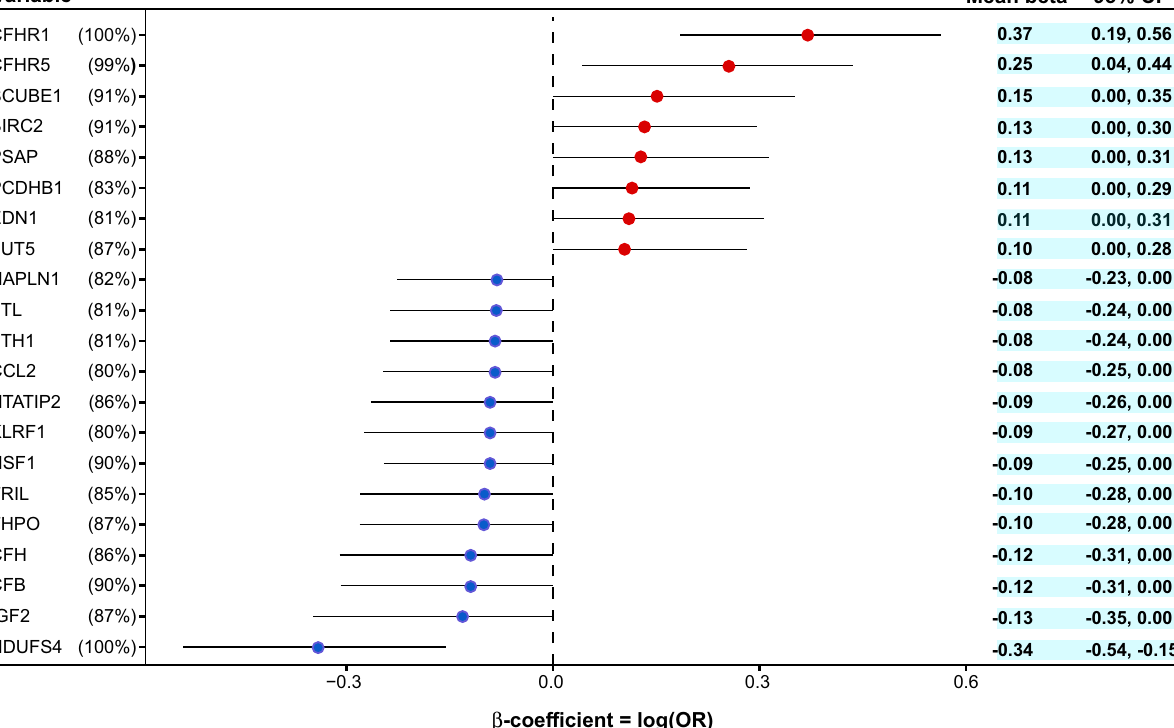
Fig. 4 Identi fi cation of serum proteins that predict late-stage AMD. The fi gure depicts protein predictors for late-stage AMD using a data-driven nonparametric bootstrap and LASSO regression analysis (see Methods section for more detail). On the left, we show 21 protein variables that appear in at least 80% of bootstrap iterations, while the mean estimates and 95% con fi dence intervals (CIs) are shown on the right. The percentage of iterations with non-zero coef fi cients for the protein variables is shown in parenthesis. Each center data point represents the mean beta-coef fi cient = log(odds ratio) with the 95% CIs as error